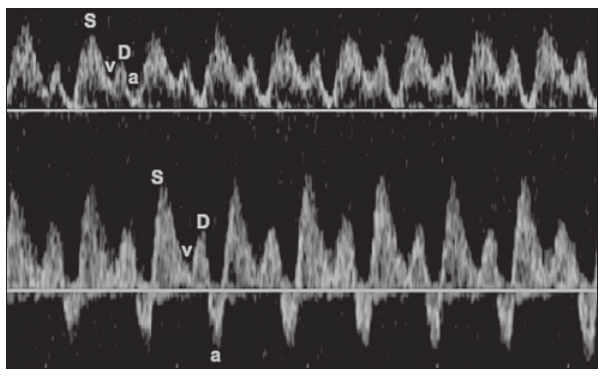
Figure-4: At the top a diphasic ductus venosus waveform of a canine fetus; at the bottom a triphasic ductus venosus waveform of another fetus. S=Ventricular systole, v=Atrial diastole, D=Ventricular diastole, a=Atrial